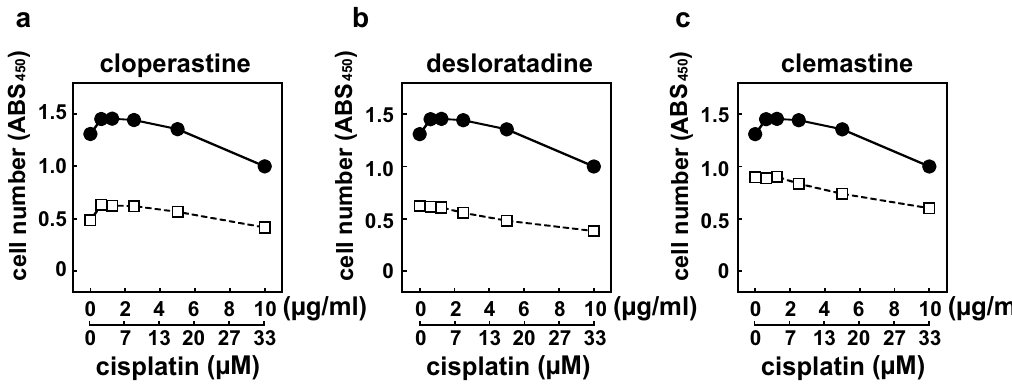
Figure 2. Cisplatin cytotoxicity toward HeLa cisR cells is not synergistically enhanced by H1 receptor antagonists. HeLa cisR cells were cultured for 3 days in the absence (closed circles) or presence (open square) of 40 µM cloperastine ( a ), 30 µM desloratadine ( b ), or 10 µM clemastine ( c ) with the indicated concentrations of cisplatin. Cell numbers during the final 5 h of the culture were evaluated using WST-8 colorimetric assays. The results are presented as means ± S.D. of quintuplicate (n = 5) samples. Three separate experiments yielded essentially the same